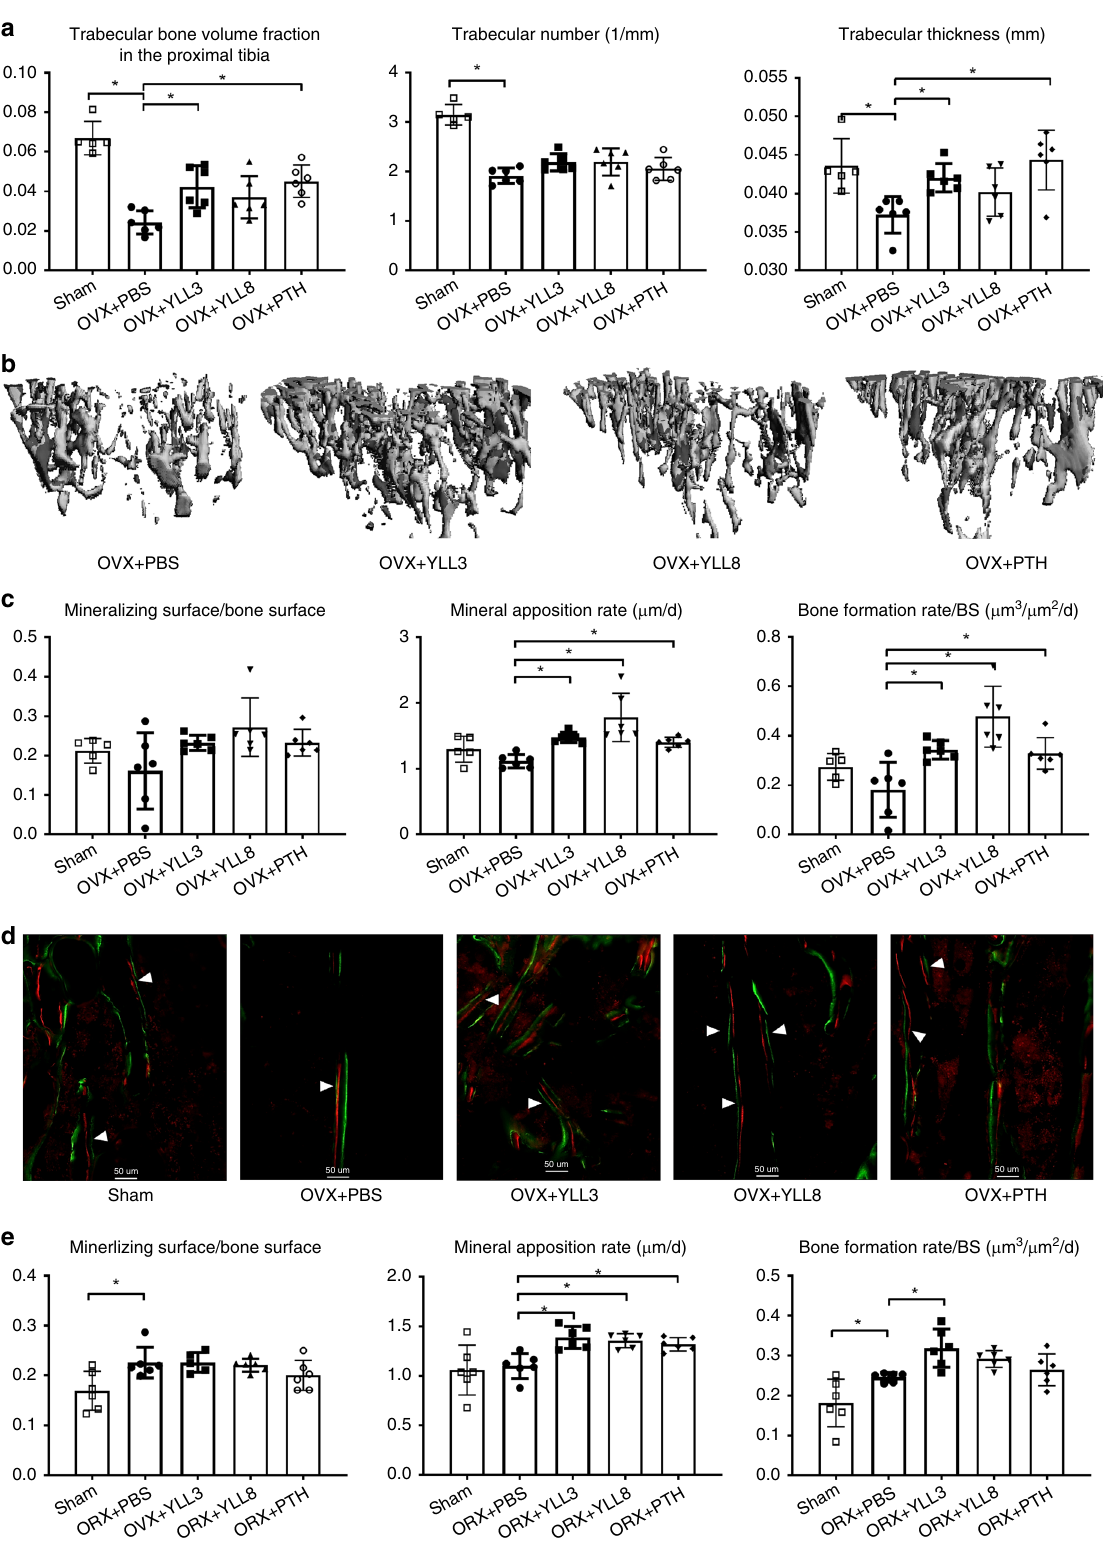
OPC-targeting peptides increase callus mineralization . Since the recruitment and activation of the endogenous osteoblast lineage cells during fracture healing is a crucial step to repair the fracture 29 , we next thought to determine if the osteoprogenitor cell-targeting peptides would expedite fracture repair